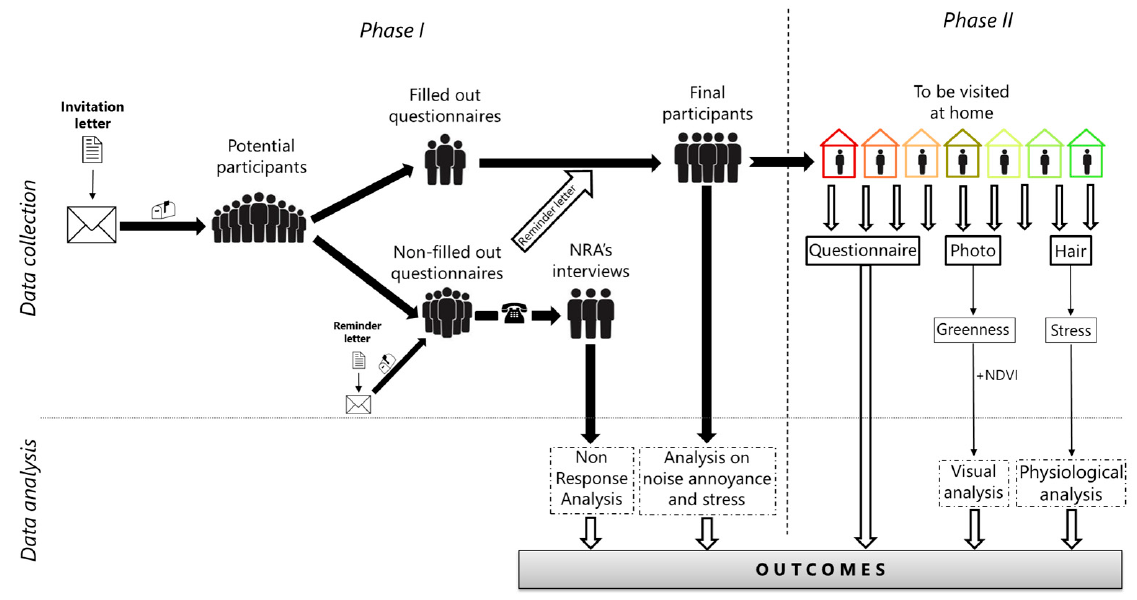
Figure 3. Graphical overview of the workflow chart of the field survey.